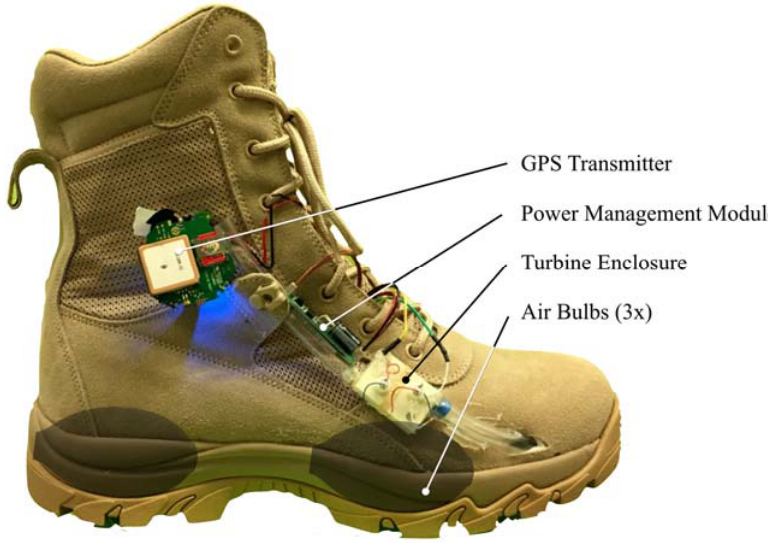
Figure 4. Prototype combat boot fitted with energy harvesting system.